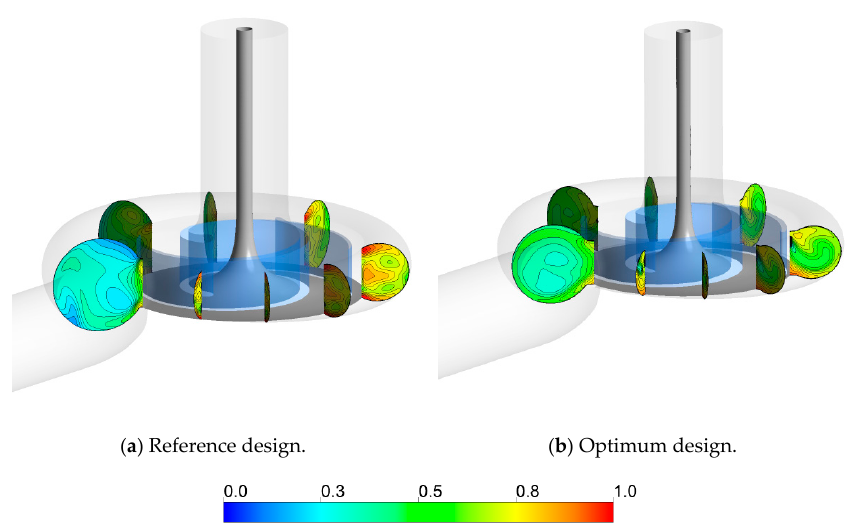
Figure 22. Velocity distributions inside the volute.